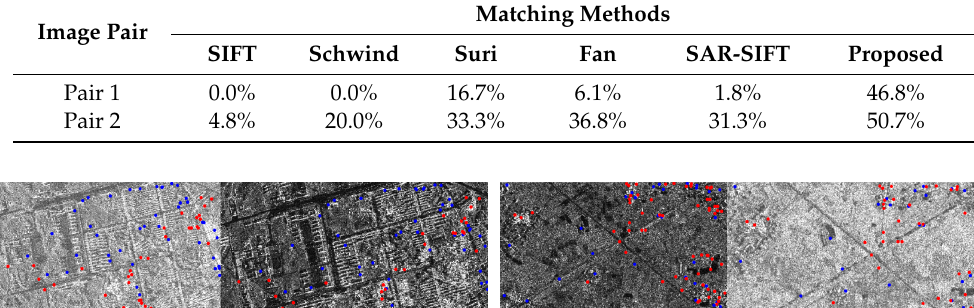
Table 10. NCM values of each method for SAR and optical images.